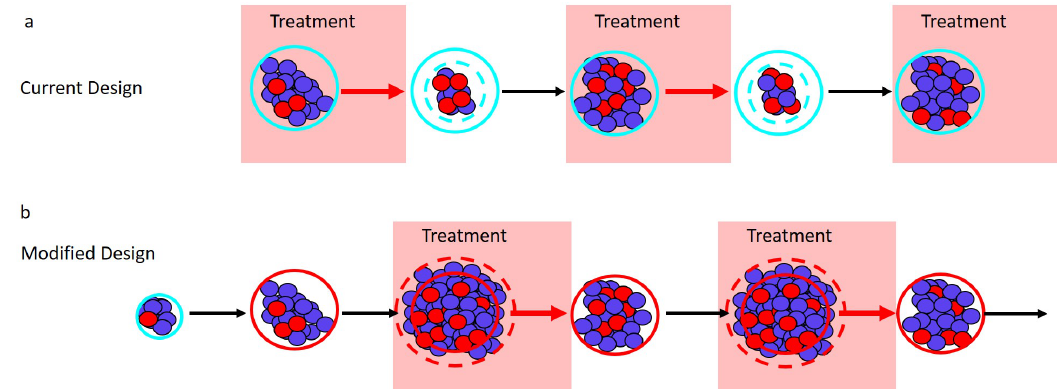
Figure 2. Adaptive therapy designs. PSA is used as a proxy for tumor burden. ( a ) Current adaptive therapy design. Treatment decisions are based on the “50% rule” using the patient’s initial pretreatment baseline PSA (solid blue circle). Treatment is stopped when the PSA falls to 50% of the baseline PSA (dashed blue circle) and is re-initiated only once the PSA returns to its initial baseline. ( b ) Modified regimen design. If the initial baseline PSA (blue circle) is low, the PSA is allowed to increase to a larger acceptable baseline PSA (solid red circle). Treatment begins when the PSA exceeds the acceptable baseline by a measurable amount (dashed red circle) and stops once the PSA returns to the acceptable baseline (solid red